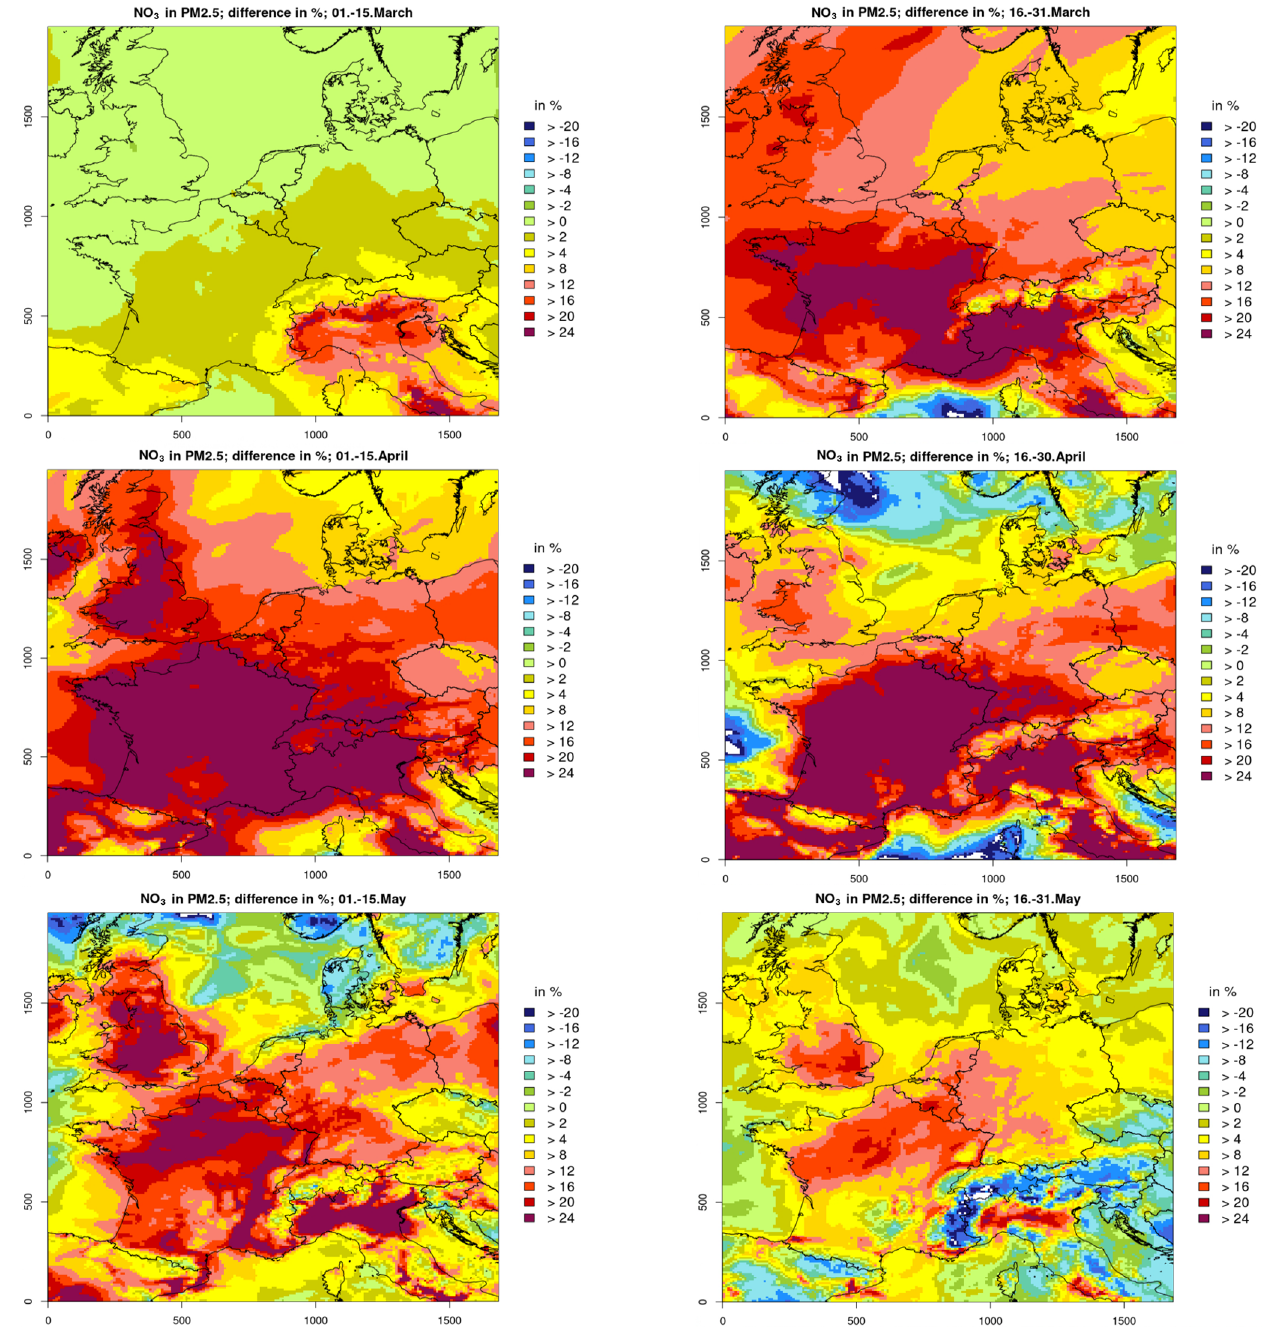
Figure A9. CMAQ results for relative particulate nitrate (NO − ) concentration reductions due to lockdown measures (noCOV – COV run) in 3 central Europe between 1 March and 31 May 2020 in half-monthly intervals; positive values denote